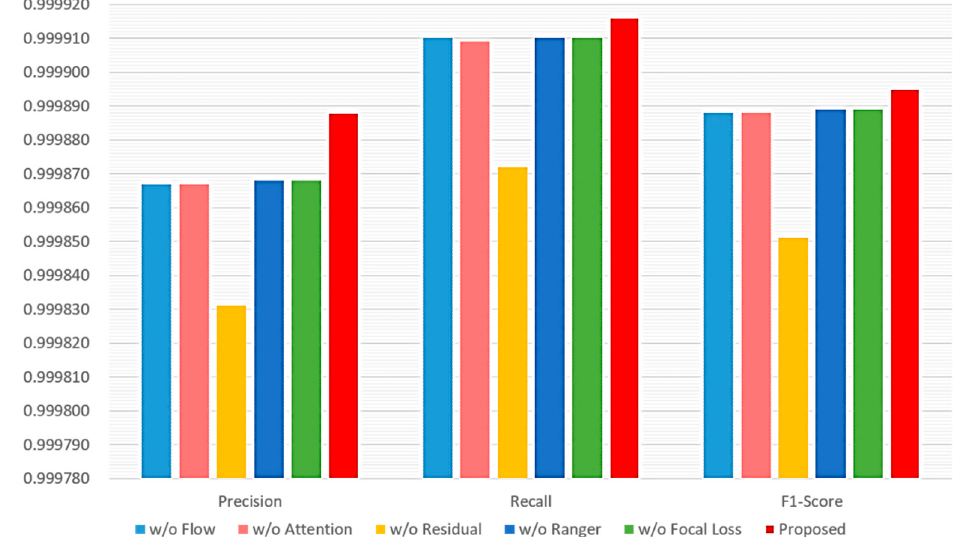
Figure 10. Performance impact of various schemes adopted by the proposed method.